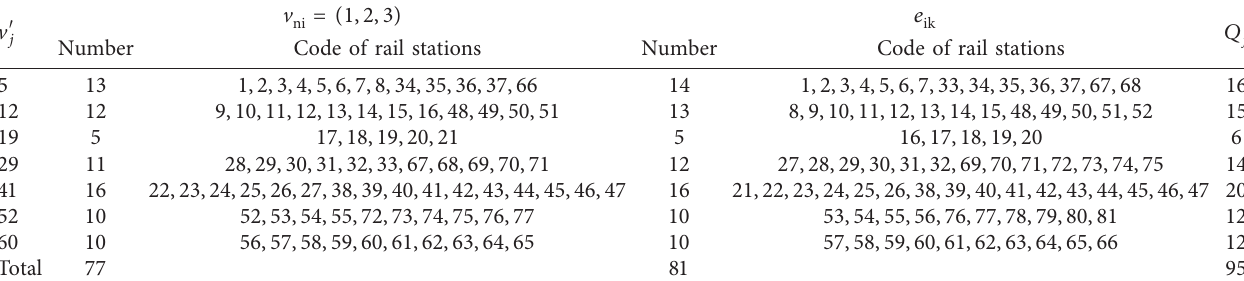
Table 3: Simulation results in scenario 1.